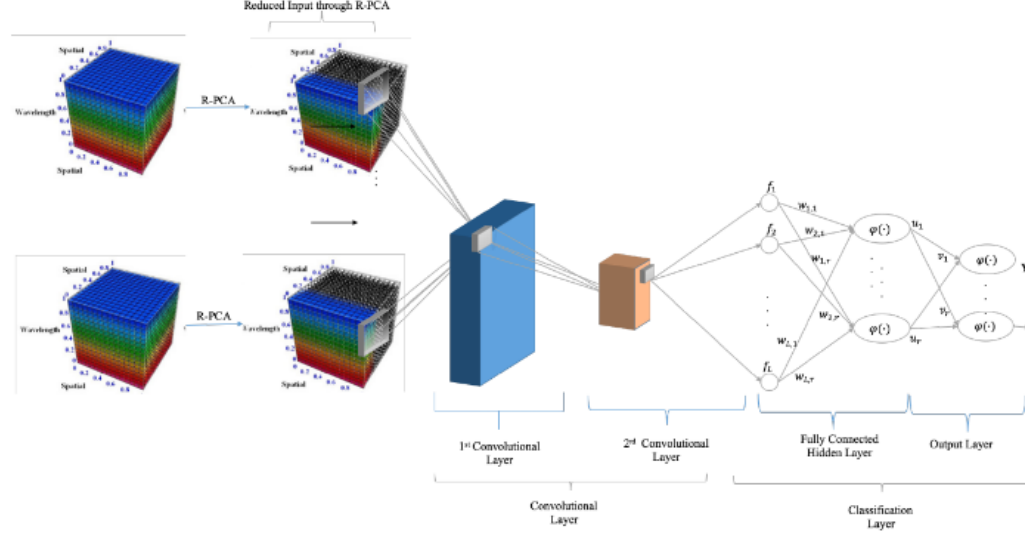
Figure 1: Deep Learning Architecture for